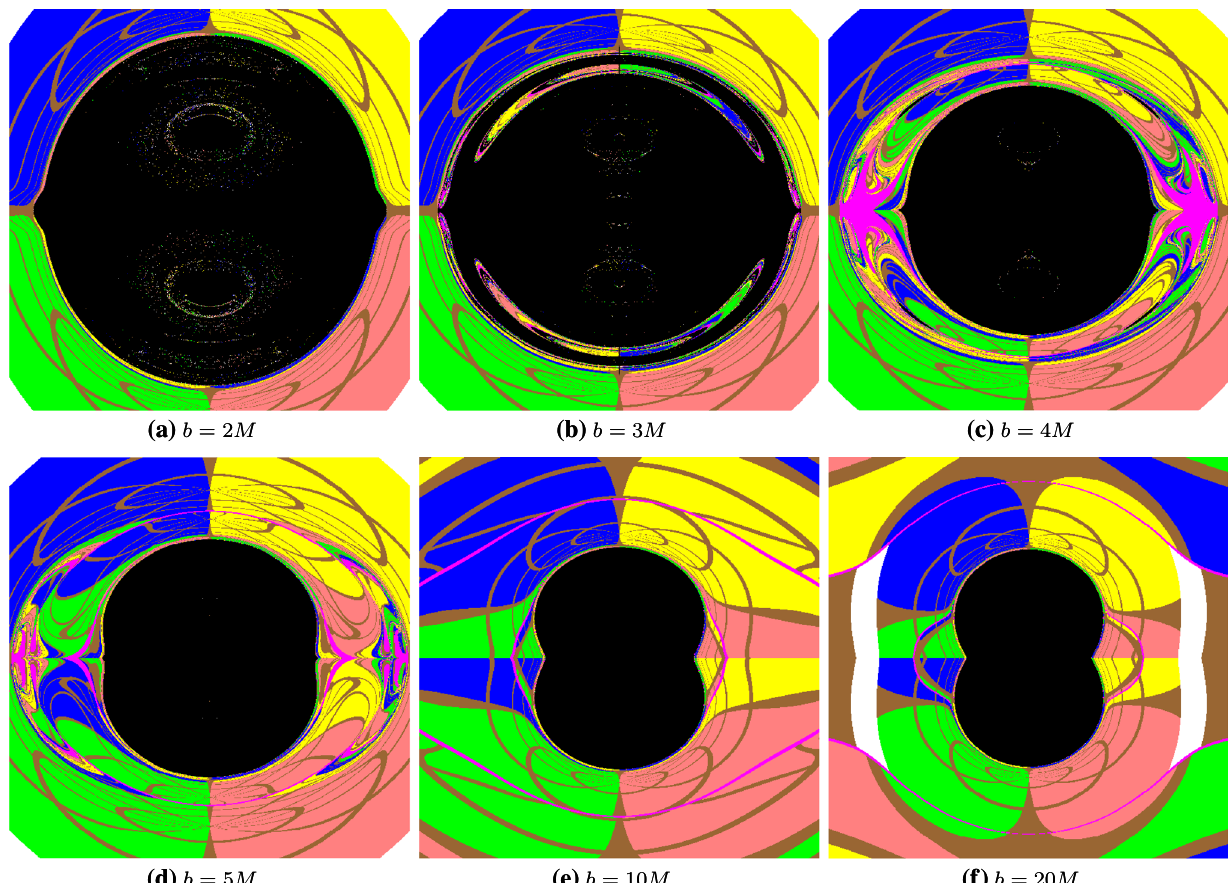
Fig. 2 The change of black hole shadow on the Weyl radius b . Here we set the ring mass M = 1 . 5 M and the black hole M = 1, and the observer locates in the position with r obs = 50 M and θ obs = π/